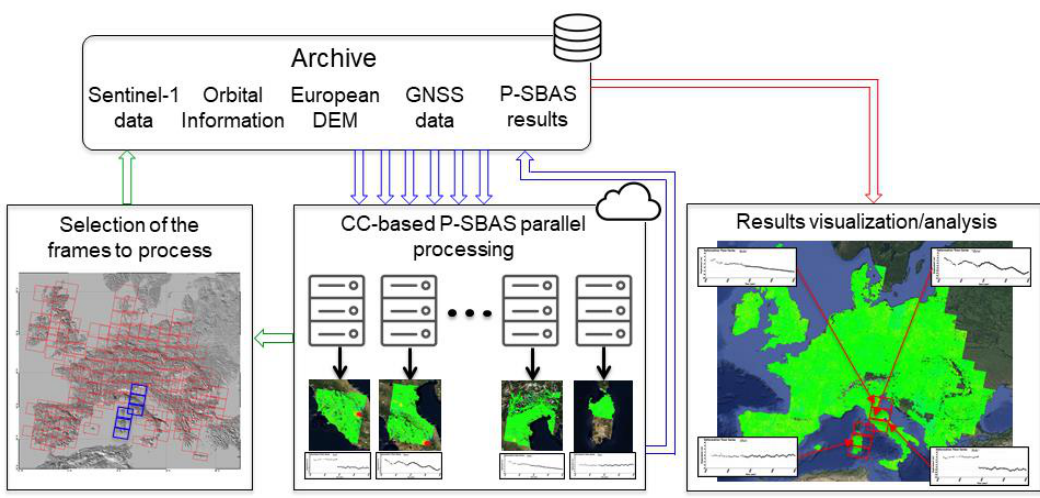
Figure 2. Workflow of the automatic CC-based pipeline implementing the S-1 IWS P-SBAS processing. Green, blue and red arrows represent information exchange, data transfer and results visualization, respectively.